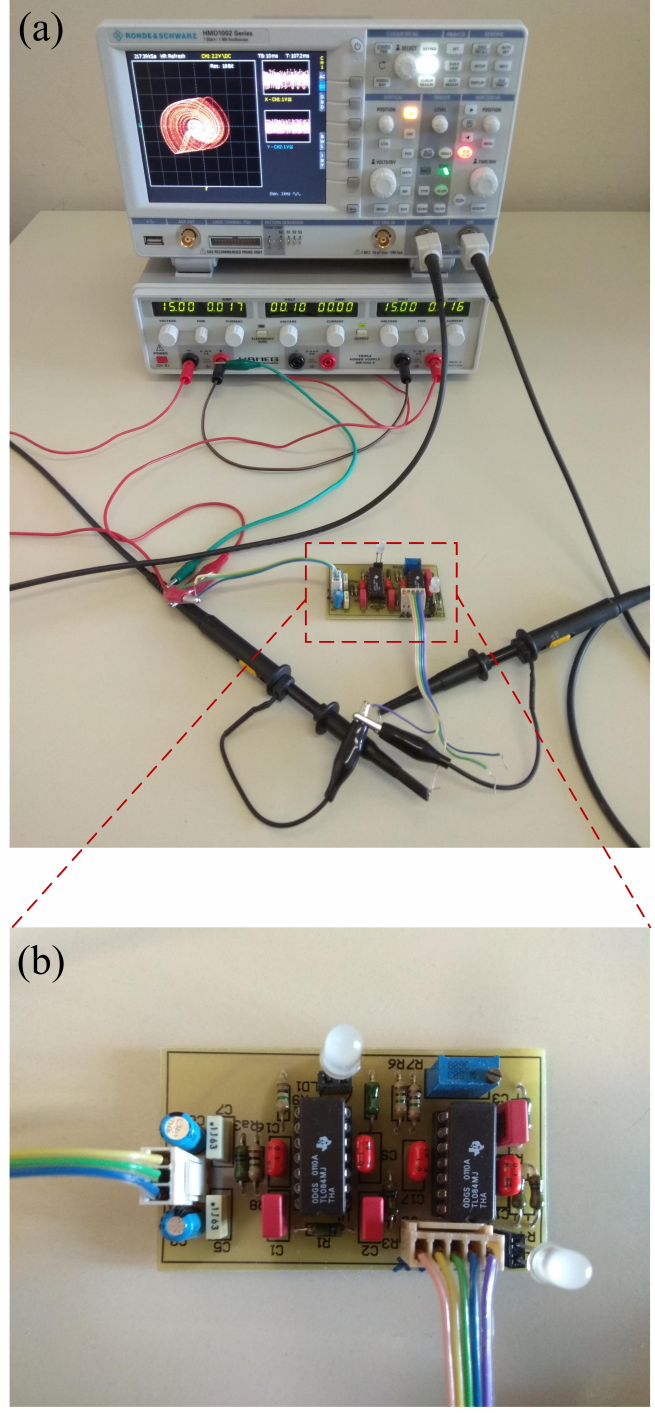
Figure 2. ( a ) The experimental setup and ( b ) the realization of the proposed circuit of Figure